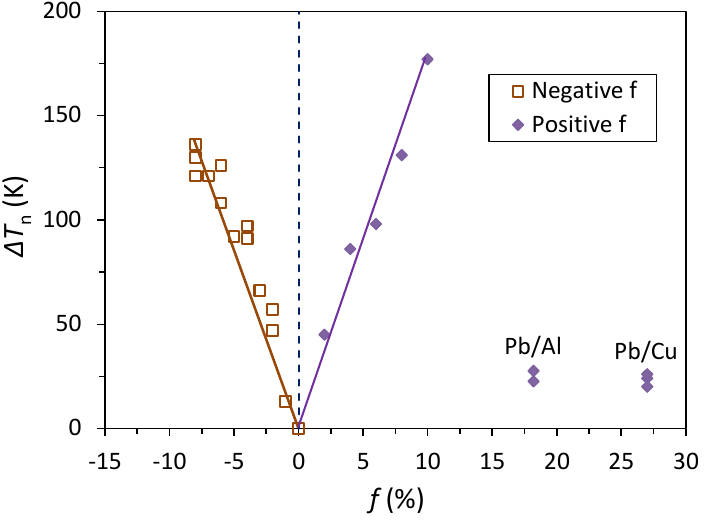
Figure 10. Nucleation undercooling ( Δ T n ) obtained by MD simulations as a function of lattice misfit ( f ) [49]. The data points for the Pb( l )/Cu( s ) system (as labelled) are from this work, and those for the Pb( l )/Al( s ) system (as labelled) are from Ref. [48] and the rest of data points are from Refs. [35,36].